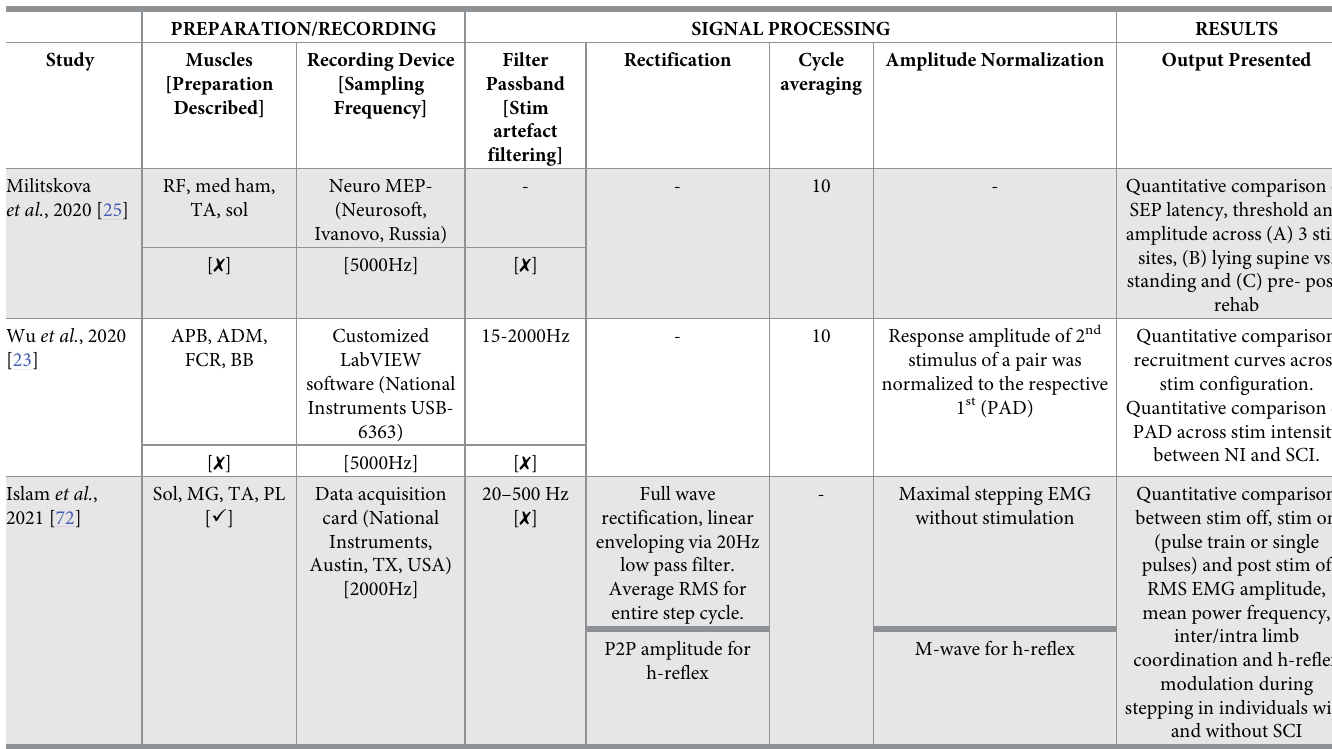
SCIP2P amplitude for h-reflex